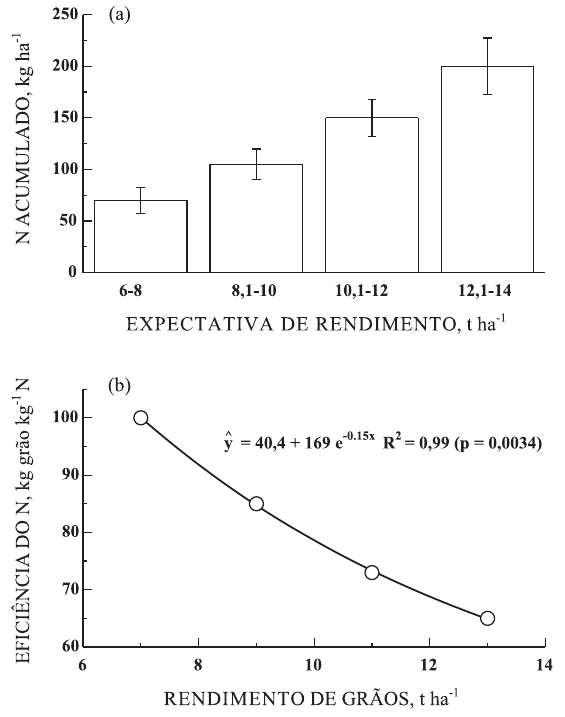
Figura 2. Quantidades de N acumulado na matéria seca do milho em diferentes faixas de rendimento de grãos da cultura (a) e eficiência do N absorvido (produção de grãos por kg de N absorvido)